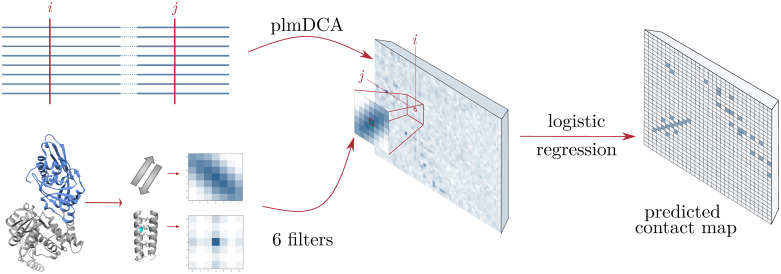
General scheme of FilterDCA: Our approach combines the results of plmDCA applied to two-domain MSAs with structural filters constructed as average contact matrices using 6 contact classes.Structural supervision is used to learn a logistic regression based on the plmDCA score itself, and the best correlation with one of the six structural filters.